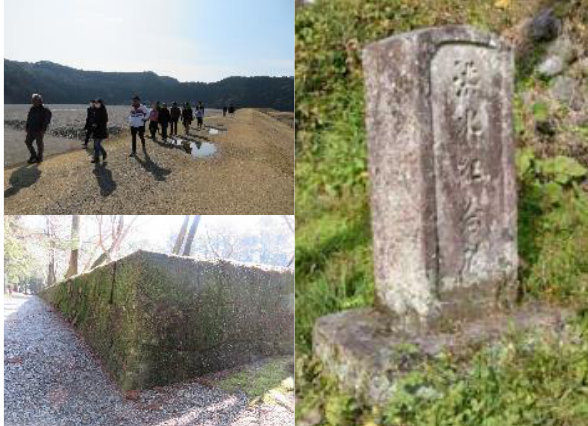
Figure 11. Photos of the disaster remains: a) Kumano Riverbank; b) Original location of Shrine; c) Stone